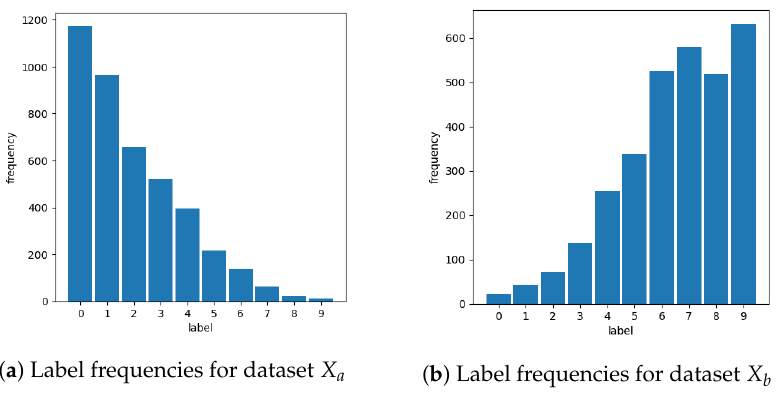
Figure 12. Frequency with which each digit occurs in two datasets of handwritten